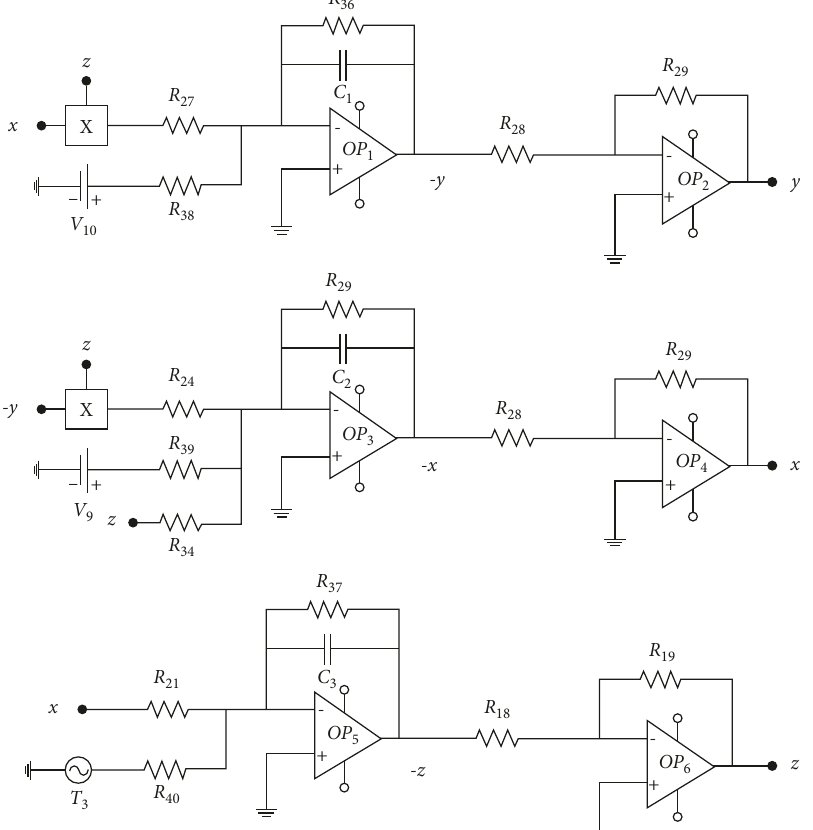
Figure 17: Circuit diagram with the sinusoidal torque driven by the PMSM.